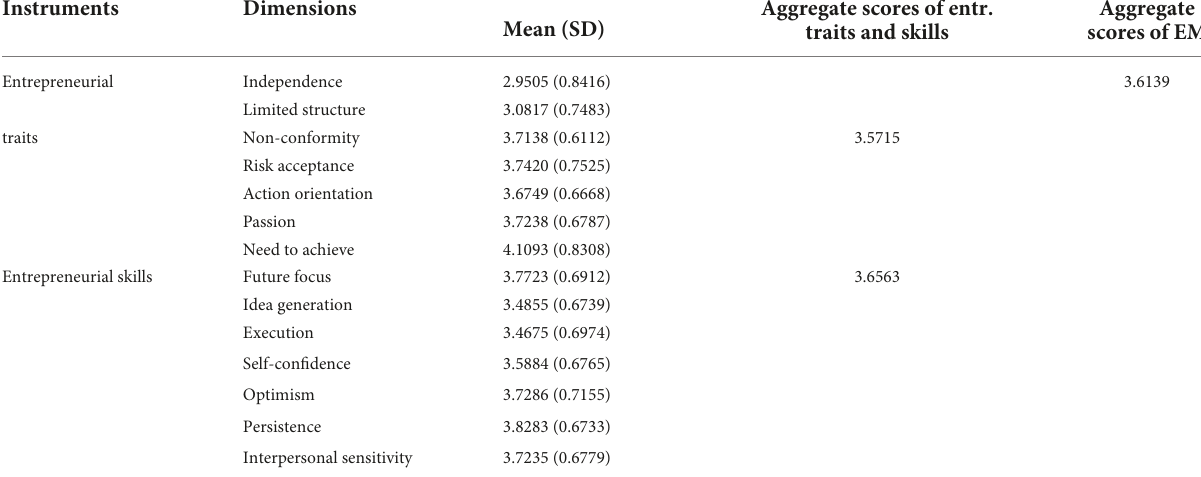
TABLE 3 Descriptive statistics